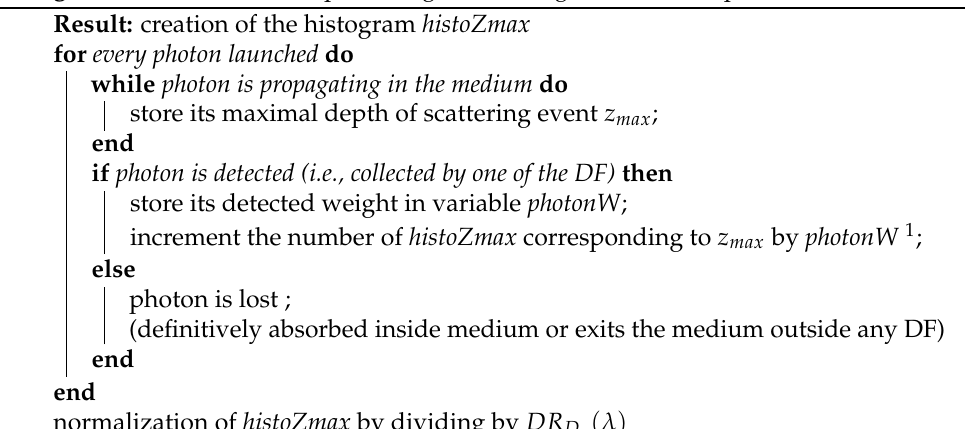
Algorithm 1: Maximum depth histogram of weighted detected